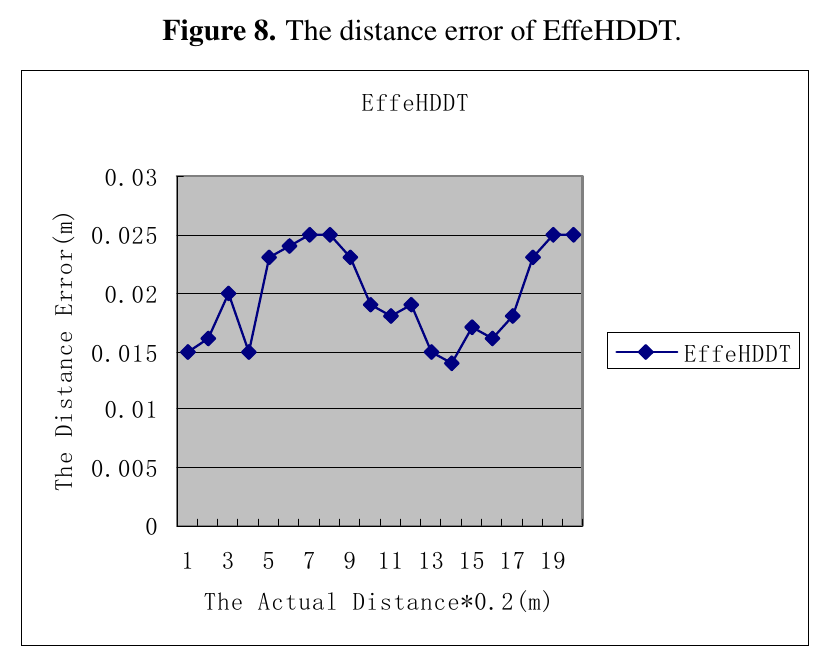
Fig.7 The distance error of